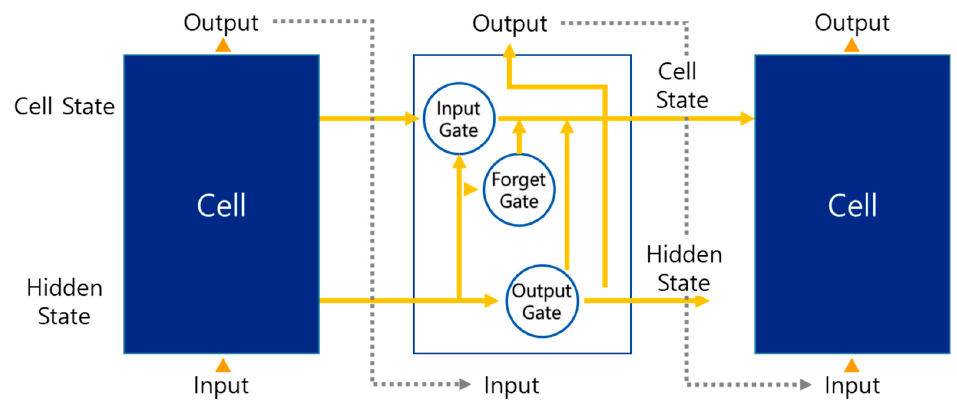
Figure 9. LSTM and memory block structure.